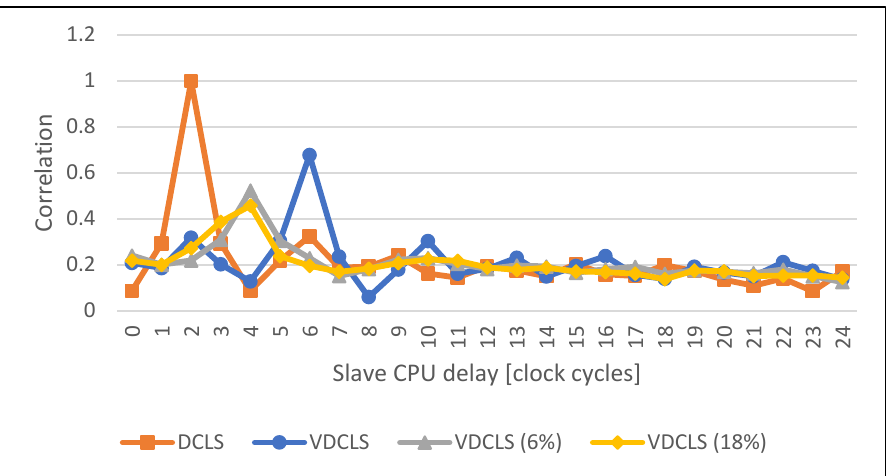
Figure 16. Comparison of the execution correlation between master and slave CPUs using VDCLS with dummy cycles insertion and legacy DCLS technique while executing the CMAC-AES algo- rithm.